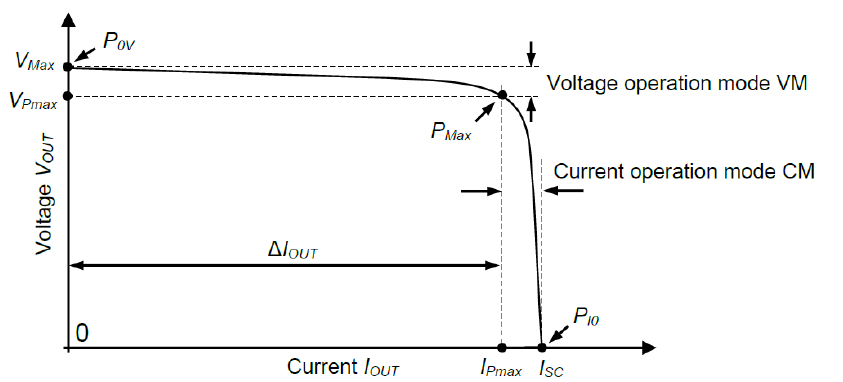
Figure 6. General output characteristic V OUT = f ( I OUT ). VM — voltage operation mode, CM — current operation mode.